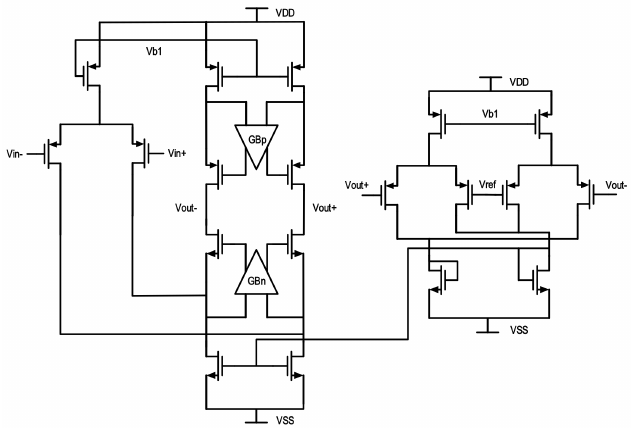
Figure 5. Fully differential amplifier in the first